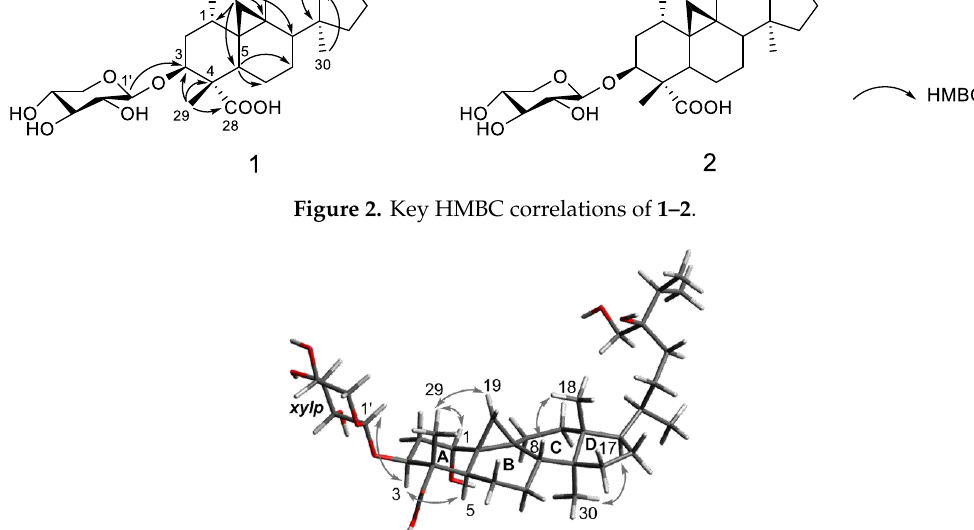
Figure 3. Key NOE correlations of 1 .